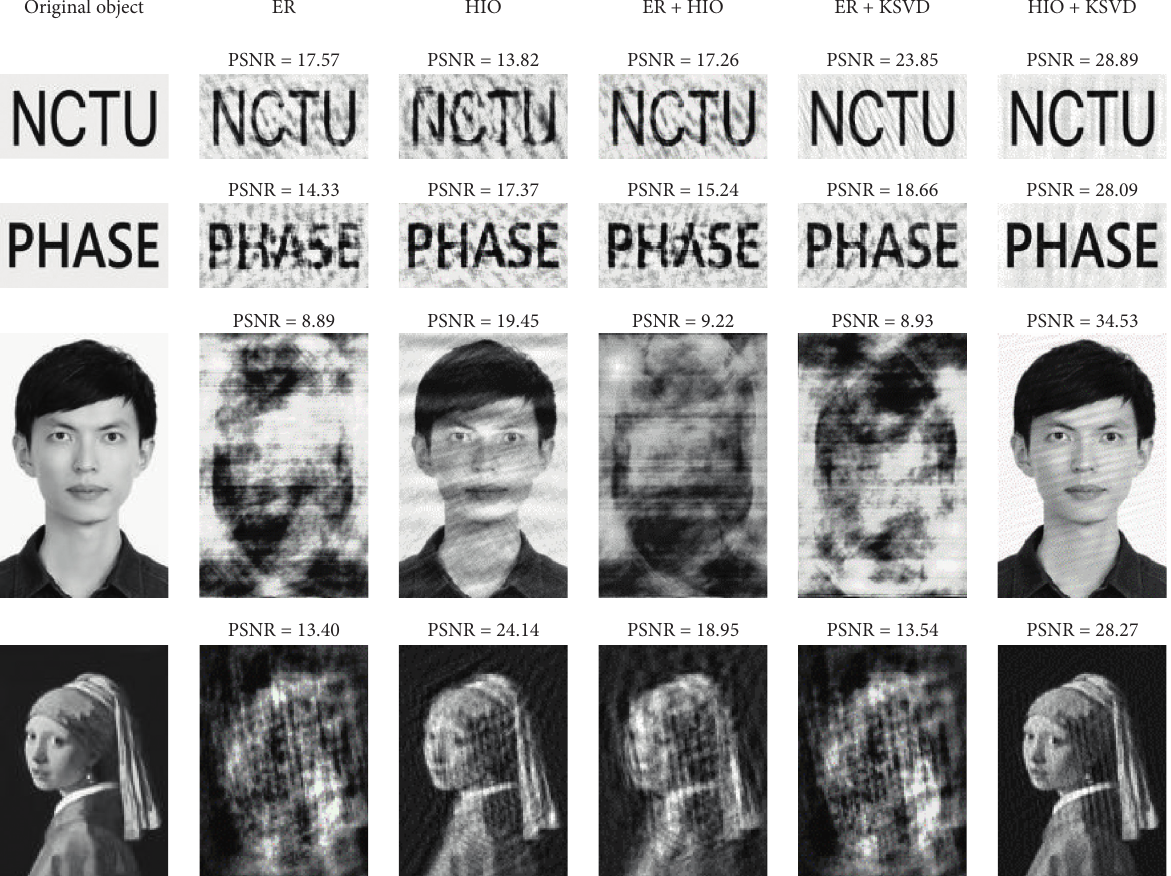
Figure 8: Reconstruction results of the five PR algorithms with the same initial Fourier phase. The total number of PR iterations in each � 800. In the ER+HIO algorithm, ER and HIO alternatively execute 200 iterations in each cycle. The proposed algorithm was set to K MAX � 160 ) raise the performance of the classical ER and methods (ER+KSVD and HIO+KSVD) applying KSVD every 160 iterations ( K cycle HIO algorithms to get better reconstruction